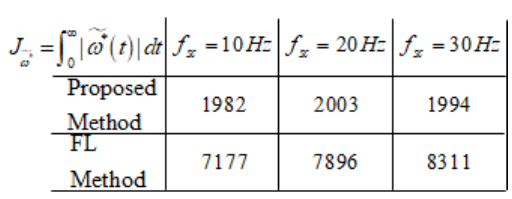
Figure 8. Quantitative speed tracking performance comparison